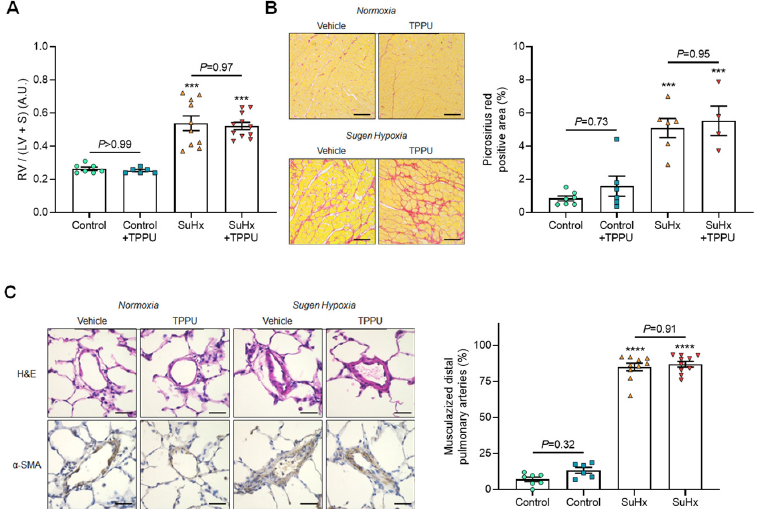
Figure 2. Values of the Fulton index (right ventricular (RV) weight divided by left ventricular + septum weight (LV+S)) ( A ); representative images and quantification of Picrosirius red staining of tissue section of right ventricles ( B ); representative images of haematoxylin and eosin-, α -smooth muscle actin, and quantification of the percentage of muscularized distal pulmonary arteries ( C ), obtained in normoxic control rats and in rats receiving Sugen 5416 associated with 3-week hypoxia (SuHx) treated with vehicle or with the soluble epoxide hydrolase inhibitor TPPU. One SuHx + TPPU rat died before hemodynamical measurements, presented in Figure 1. Sirius red staining was obtained in a subset of animals from each group. Scale bar: 20 µm. *** p < 0.001, **** p < 0.0001 vs. corresponding control rats.